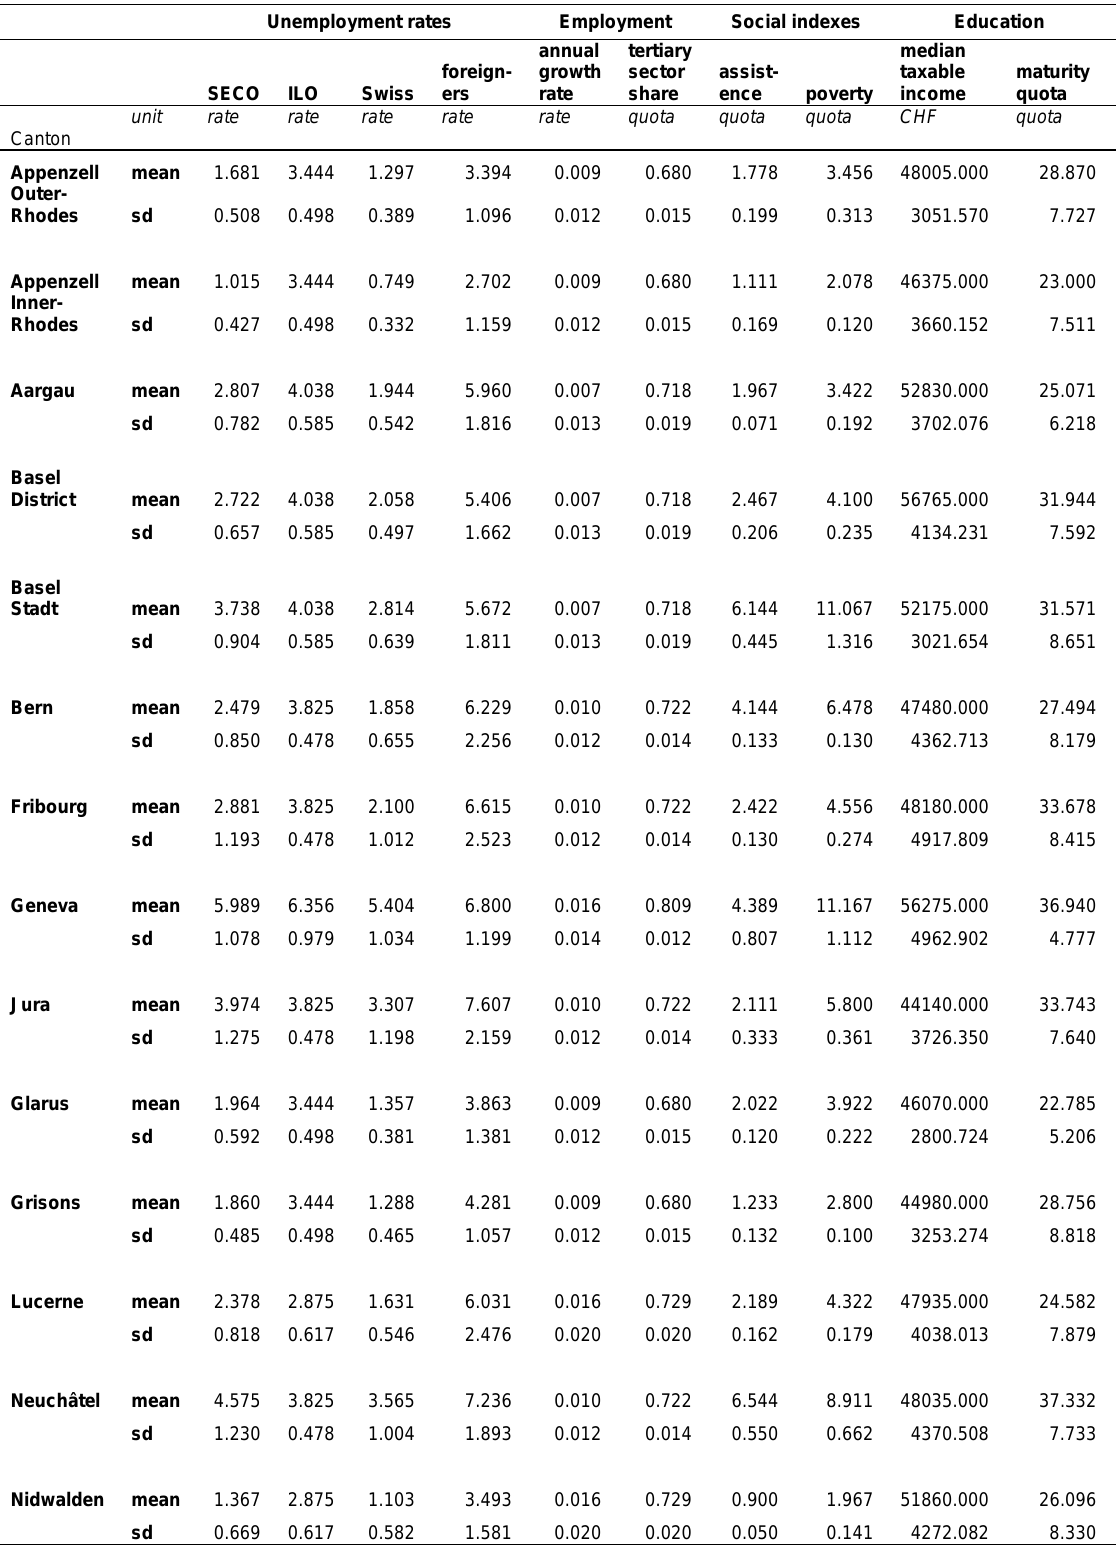
Table 7. Summary of descriptive statistics for all